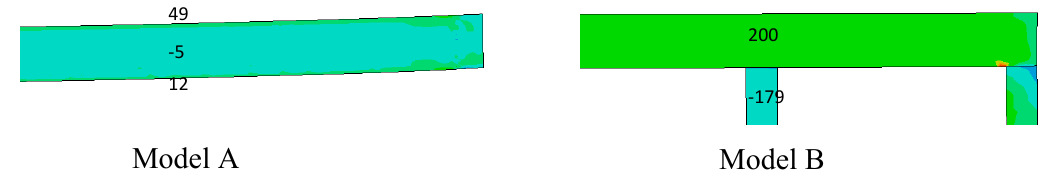
Figure 14. Residual stress distributions (MPa) in the deposited layers around the overhang area.